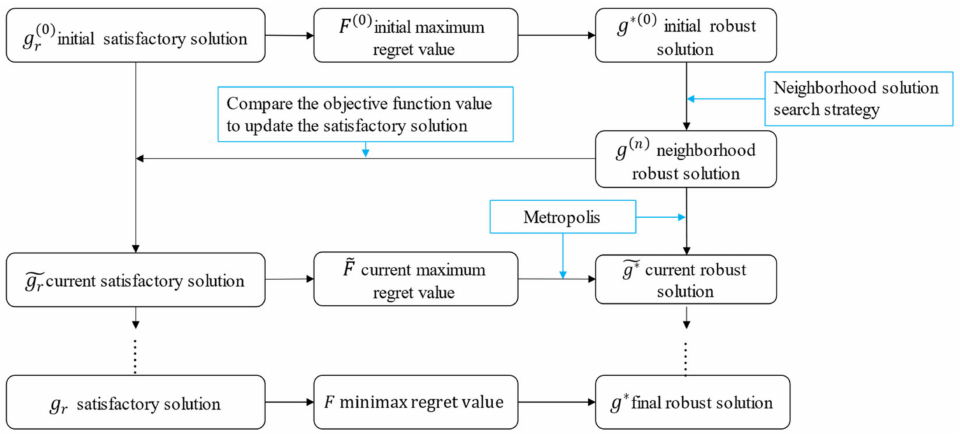
Figure 4. The algorithm of the designed